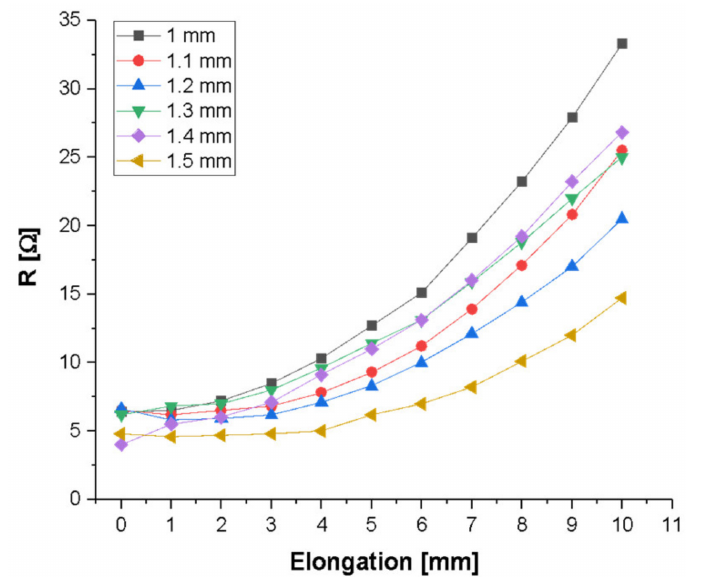
Figure A12. Resistance variation of each pattern of the DuPont PE873 screen-printed ink on the Novotex SK81SS + 06 substrate according to the